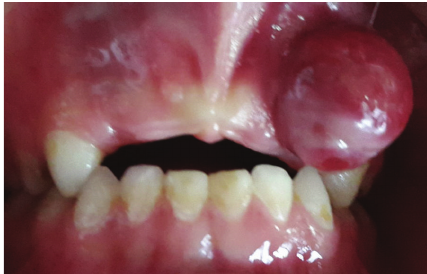
Figure3:Intraoralimmediatepostoperativeviewshowingcomplete surgical